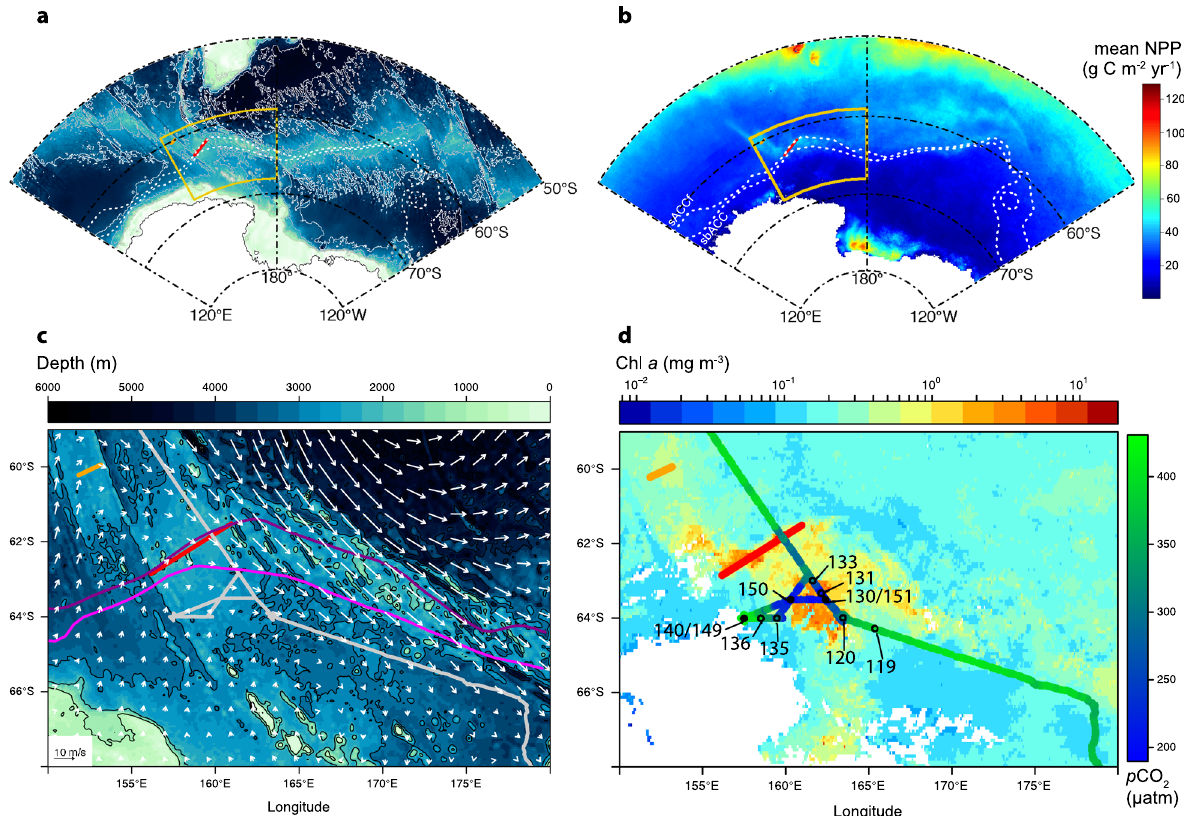
Fig. 1 Bathymetry and phytoplankton distribution in the Paci fi c sector of the Southern Ocean. On all fi gures, red and orange lines indicate the positions of the ridges KR1 and KR2, respectively 7 . The positions of southern Antarctic Circumpolar Current (ACC) front (sACCf) and the more southerly positioned southern boundary of the ACC (sbACC) 35 , are shown by the white dashed lines in a and b and by the pink lines in c . a Map of Paci fi c sector bathymetry, with yellow inset box that corresponds to the areas shown in c and d . b Map of Paci fi c sector climatological net primary production (NPP; 1997 – 2019), indicating the return of the bloom to the same location most years. c Map of bathymetry and January 2014 geostrophic currents from Dotto et al. 14 . Cruise track is shown as solid gray line. d Map of mean satellite chlorophyll a (Chl a ) from November 2013-February 2014 with underway p CO 2 overlaid along the cruise track. Stations are indicated by black circles and labeled with a station number. Closed circles indicate stations where a cast to 2000 m was conducted to sample dissolved Fe (DFe). The distance from the center of KR1 to station 150 is 168 km. Bathymetry data are from https://www.ngdc.noaa. gov/mgg/global/. White areas indicate land in a and b and an absence of valid Chl a data in d which is either land, sea-ice, or persistent cloud cover. Note that the satellite Chl a image that covers the bloom period d is a composite of multiple months and the location of the bloom in this image may not exactly match our in situ measurements. The convergence zone visible to the south of our study area c falls within the boundaries of the western side of the Ross Gyre. However, the location of this zone shifts substantially on a monthly timescale and is unlikely to impact the